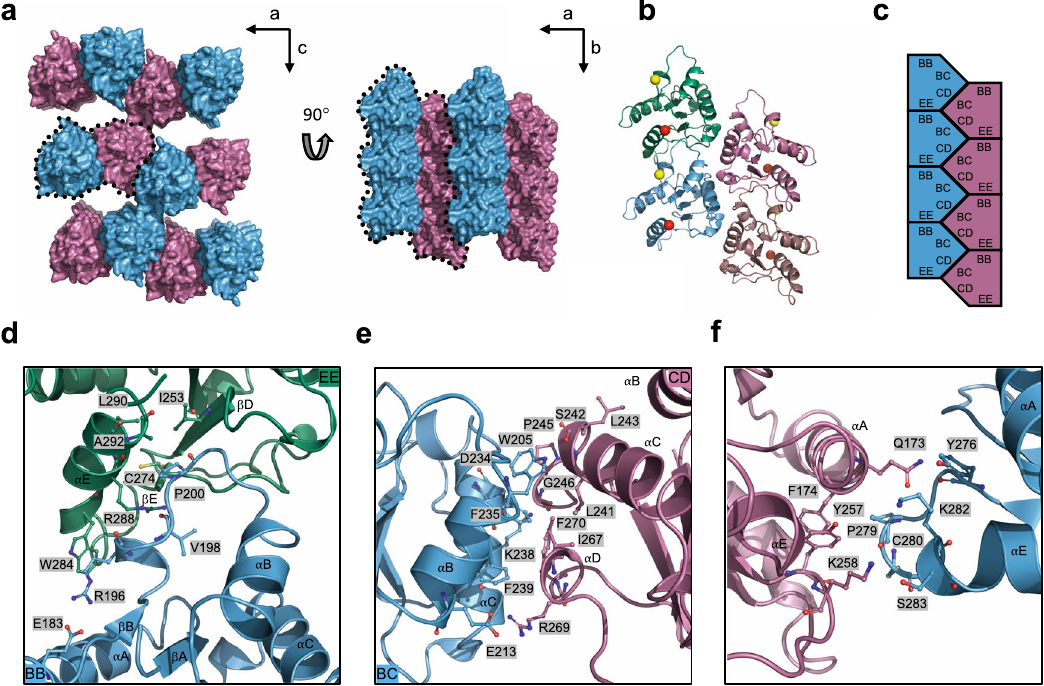
Fig. 5 Structure of the MyD88 TIR higher-order assembly microcrystal. a Surface representation of the MyD88 TIR microcrystal, consisting of two- stranded higher-order assemblies (black dotted lines). The two strands are shown in blue and magenta, respectively. b Ribbon diagram of the MyD88 TIR higher-order assembly. A yellow sphere indicates the N terminus of each TIR monomer and a red sphere indicates the C terminus of each TIR monomer. The two strands are shown in blue and green, and magenta and dark salmon, respectively. c Schematic diagram of the MyD88 TIR microcrystals and the two types of asymmetric interactions within the higher-order assembly. BB surface consist of residues in BB loop; EE surface consist of residues in β D and β E strands, and the α E helix; BC surface consist of residues in α B and α C helices; whereas CD surface consist of residues in CD loop and the α D helical region. d , e Detailed interactions within the higher-order assembly d intrastrand interface and e interstrand interface. f Detailed interactions between the two- stranded higher-order assemblies, forming the sheet